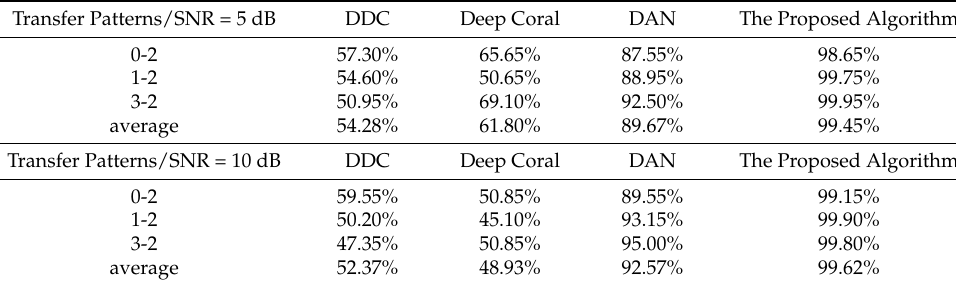
Table 4. Experimental results in unbalanced data + noise